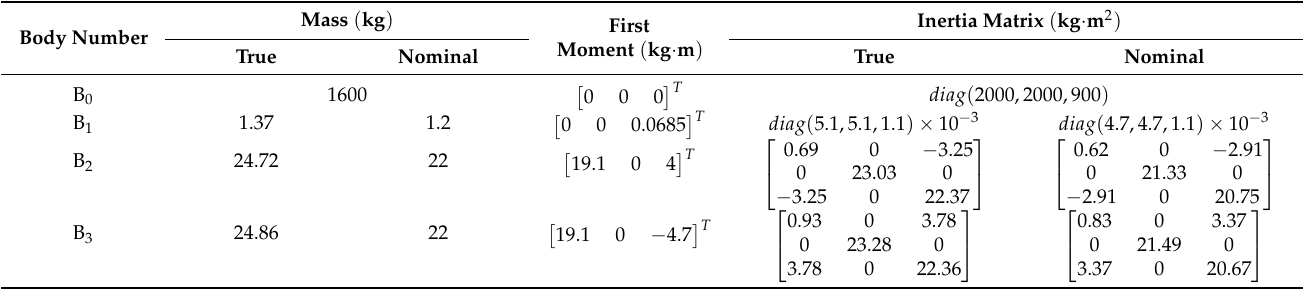
Table 1. System inertia and installation parameters.